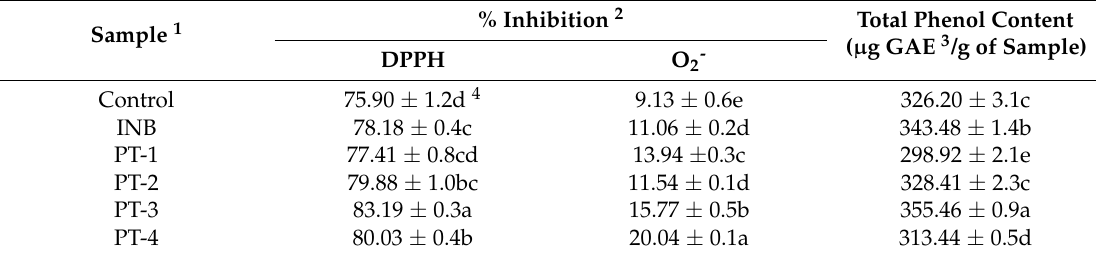
Table 6. Scavenging activities of reactive oxygen species and total phenolic contents of soybean sprouts cultivated with Indolbi (INB) or persimmon fruit powder